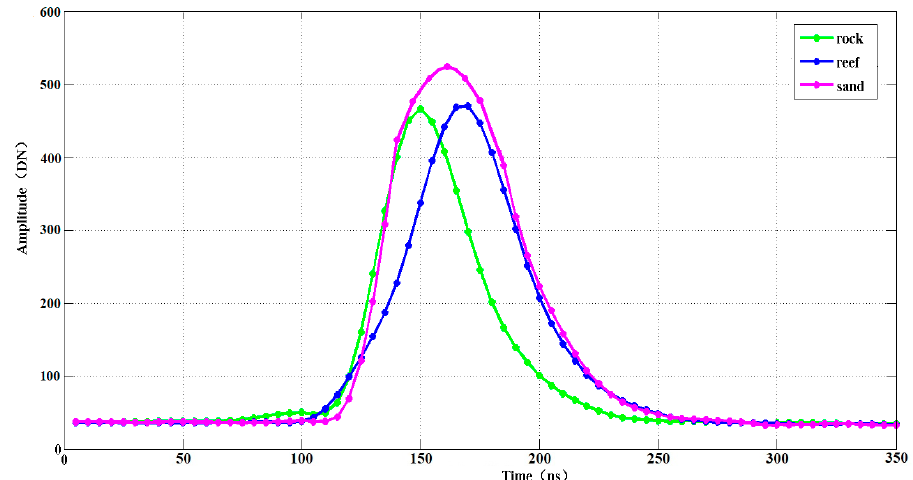
Figure 4. Location of survey area and experimental data. ( a ) Location of the whole island; ( b ) experimental data; ( c ) categories of seafloor.